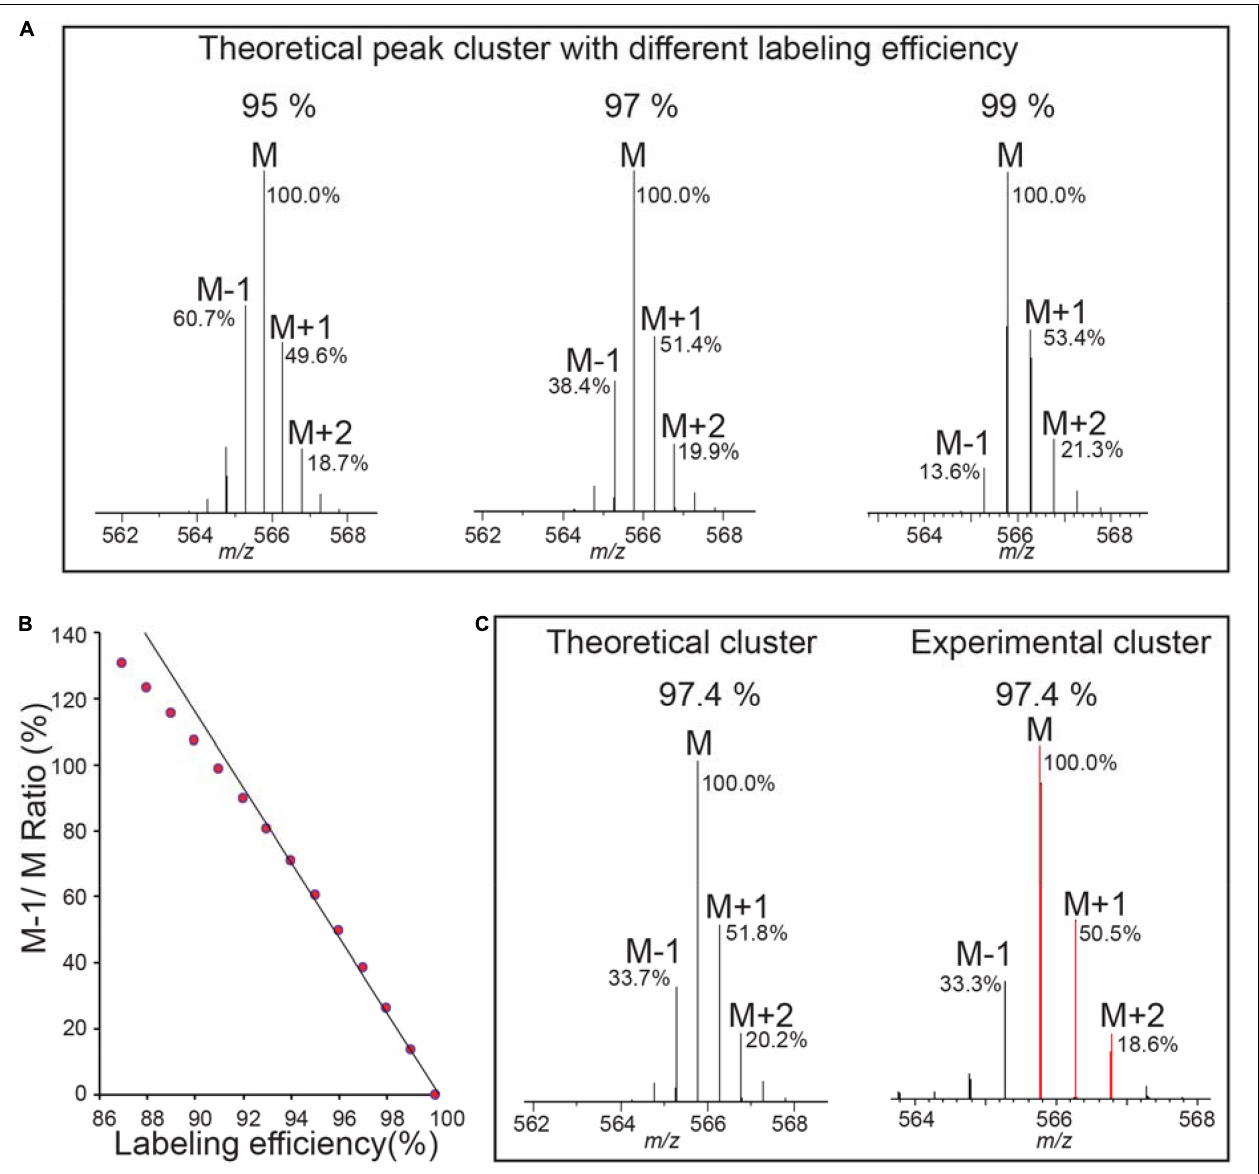
FIGURE 2 | Labeling efficiency or enrichment is determined on 15 N labeled peptides by comparing the experimental isotope pattern to the theoretical isotope profile. (A) Three plots show the theoretical isotope profile of the heavy peptide “VALEAC*VQAR” (C46 H82 O15 15N14 N1 S1) from RIBULOSE-BISPHOSPHATE CARBOXYLASES labeled at 95, 97, and 99% labeling efficiency (C*, Carbamidomethylation). The monoisotopic peak is the most intense peak in the isotope cluster for this m/z and any peaks to its left are caused by incomplete labeling. The relative abundances of M-1, M, M+1, M+2 to the M peak are labeled, with more abundance of M-1 peak indicating lower labeling efficiency. The analysis is performed using the Protein Prospector “MS-Isotope” module. (B) M-1/M ratio is reverse correlated with labeling efficiency using same peptides in (A) for calculation. (C) Labeling efficiency is determined as